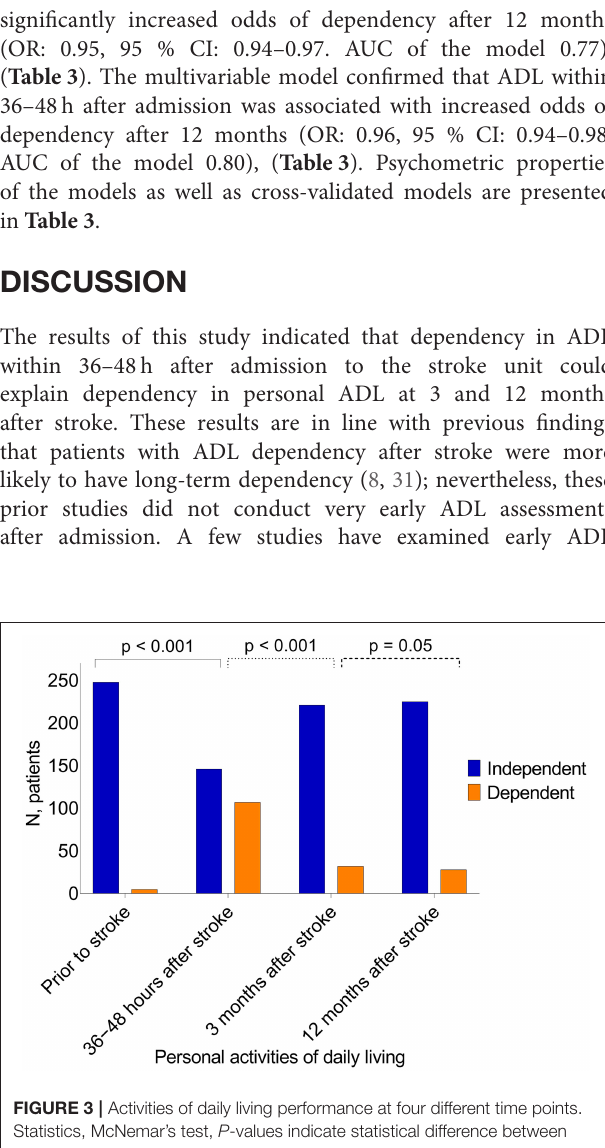
FIGURE 2 | Study flowchart.